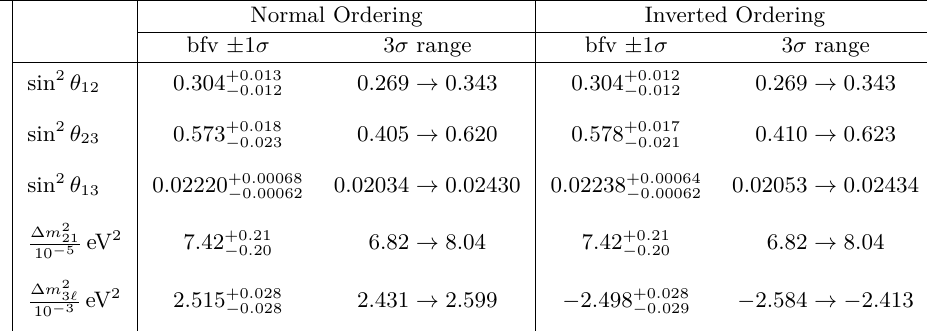
> 0 for NH and 31